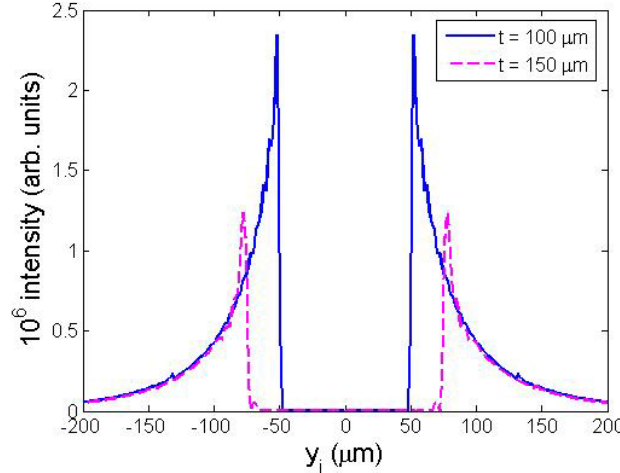
FIG. 7. (Color) 1D image formed with the ODR when a single electron center passes through a rectangular slit with various widths.